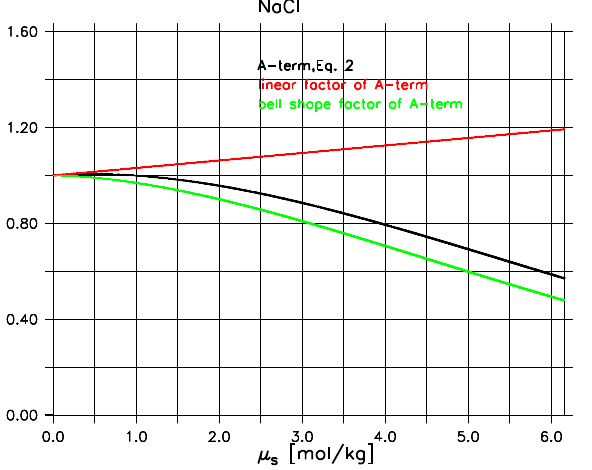
Fig. 8. B-term and its rational function and root term for NaCl . B 98 is also plotted for comparison.